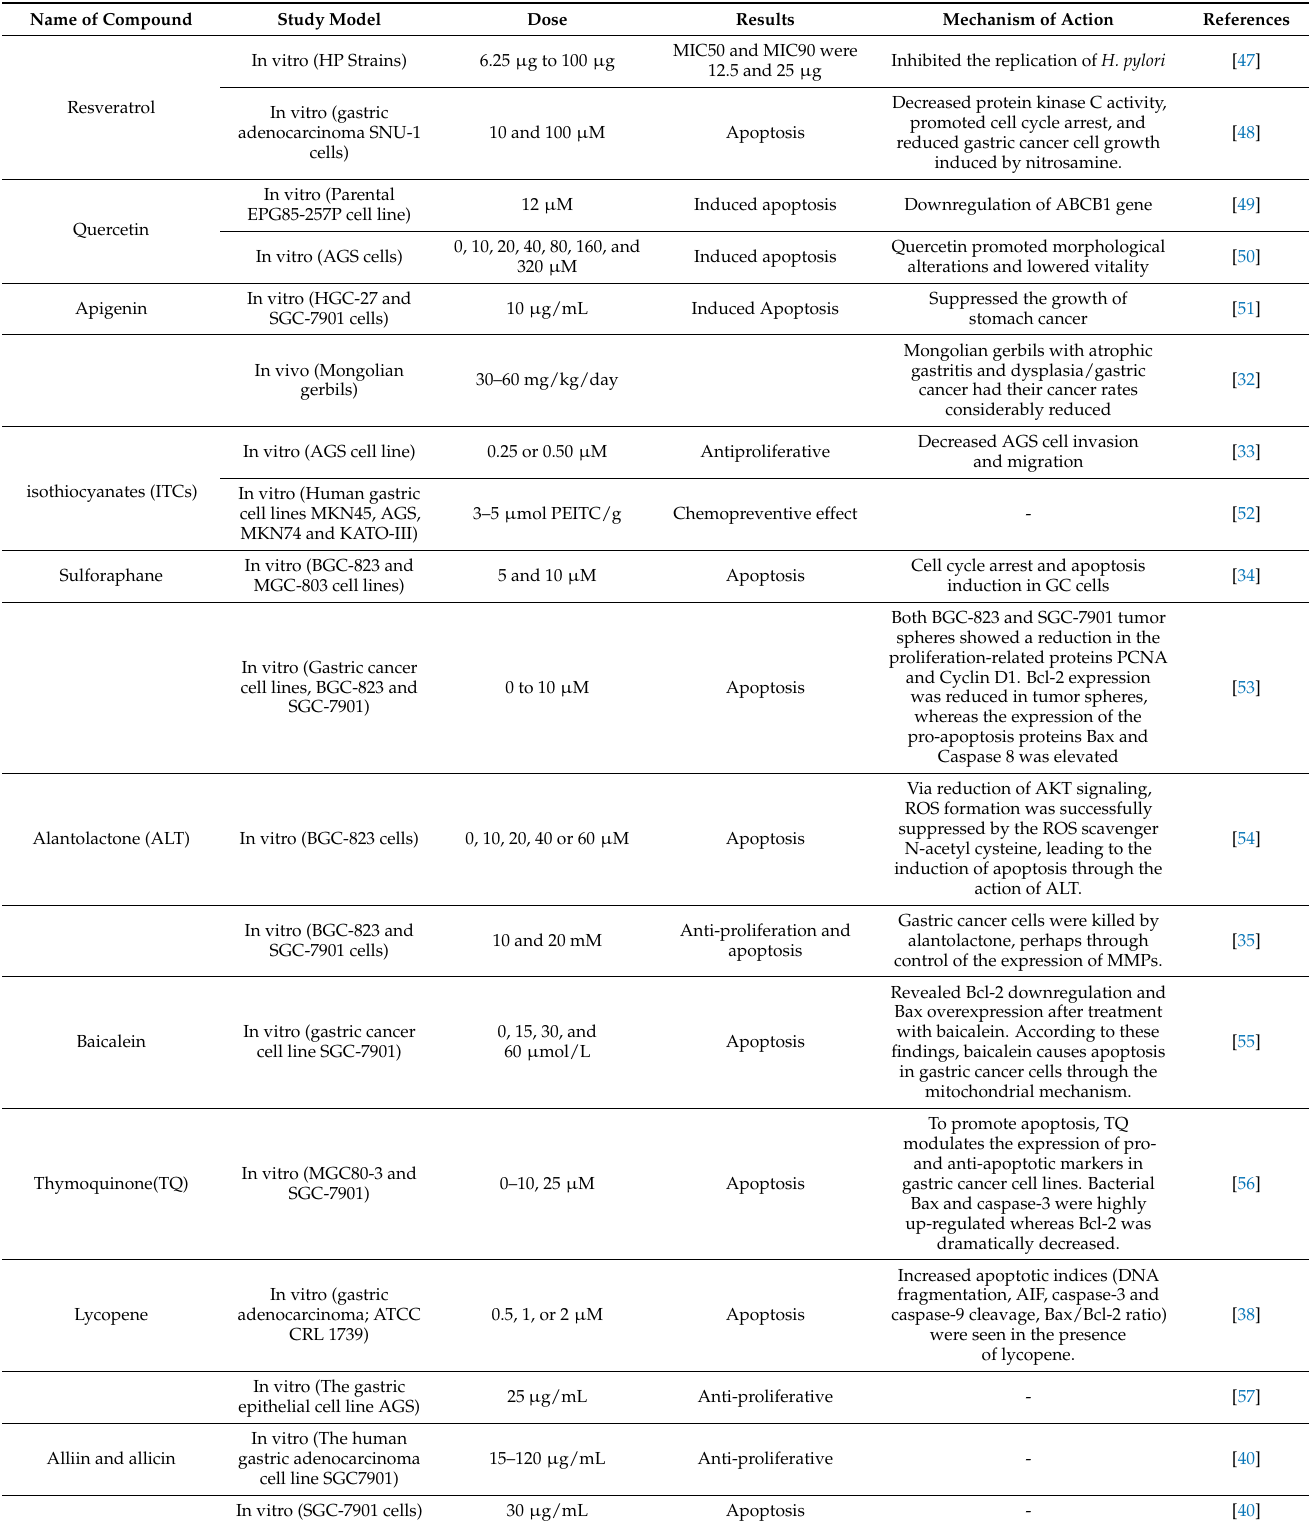
Table 1. Natural small molecules in gastric